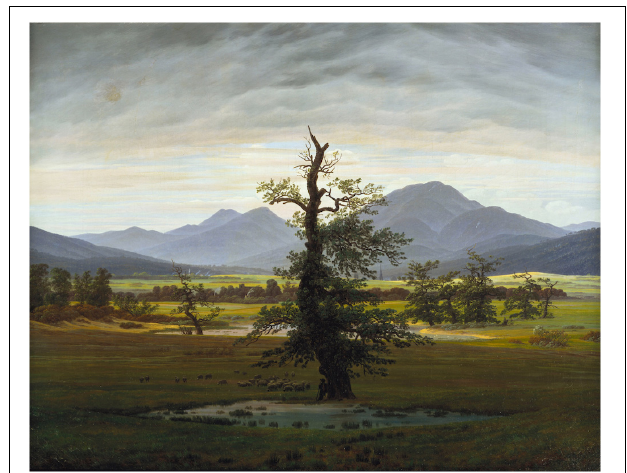
FIGURE 1 | Caspar David Friedrich, Der einsame Baum (The Solitary Tree), 1822, oil on canvas, 21.6 × 27.9 in (55 × 71 cm), Alte Nationalgalerie, Berlin, http://commons.wikimedia.org/wiki/File:Caspar_David_Friedrich_-_Der_ einsame_Baum_-_Google_Art_Project.jpg.